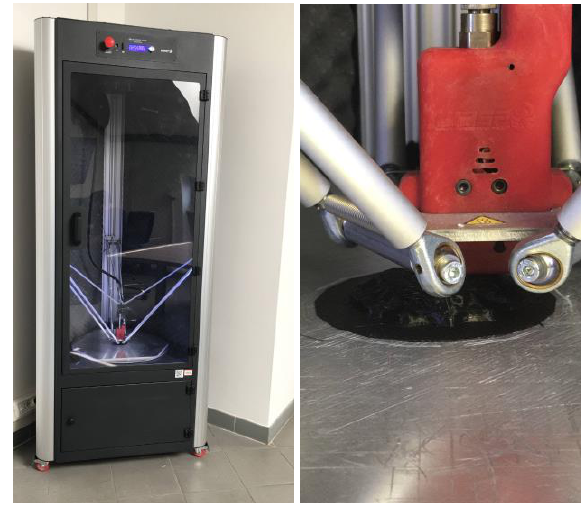
Figure 17. 3D printer working.